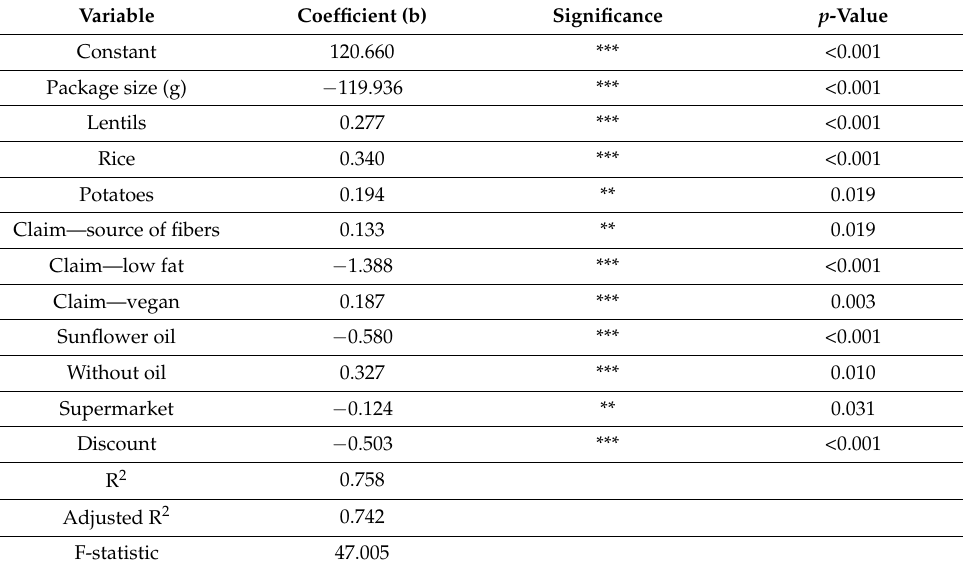
Table 8. Parameter estimates in our hedonic price model